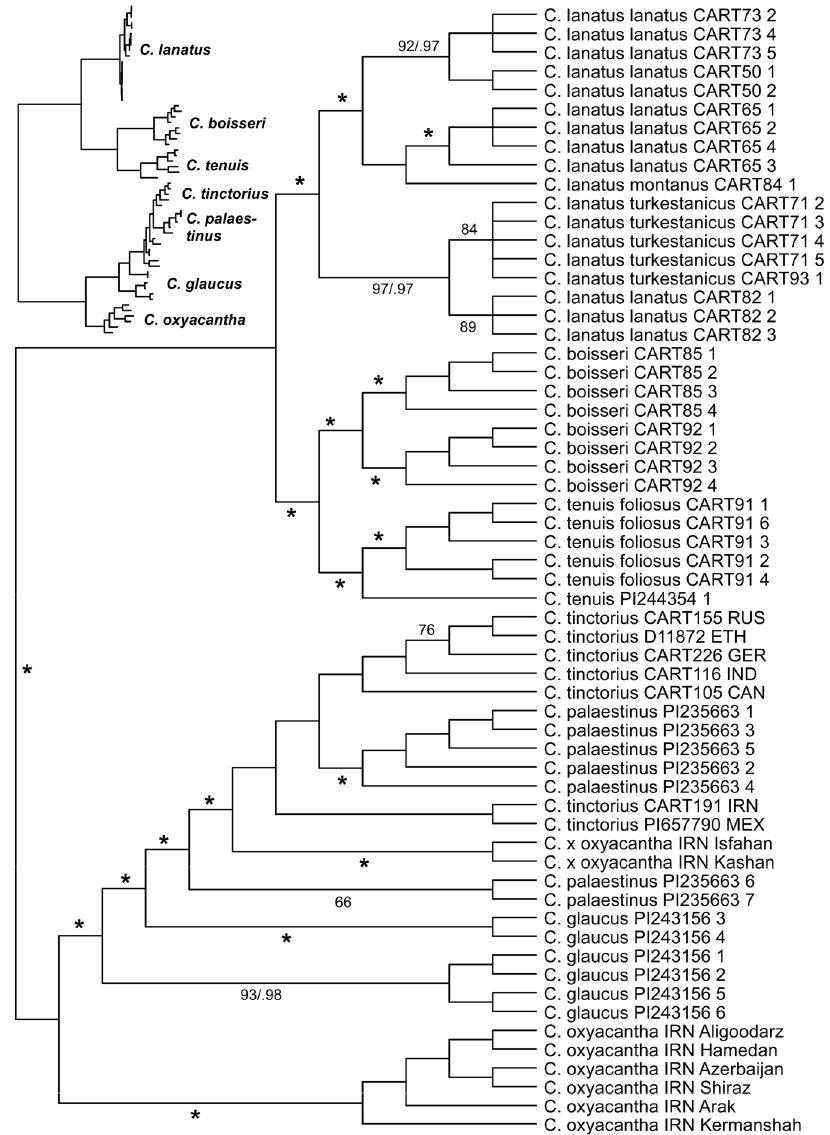
Figure 1. Unrooted strict consensus tree of 2484 MP trees derived from the analysis of GBS data. Asterisks indicate branches with support values of ≥ 98% in MP bootstrap analysis and posterior probabilities ≥ 0.99 in Bayesian phylogenetic inference for the backbone clades of the tree. The inserted tree on the left is one of the most parsimonious trees and indicates branch lengths in MP